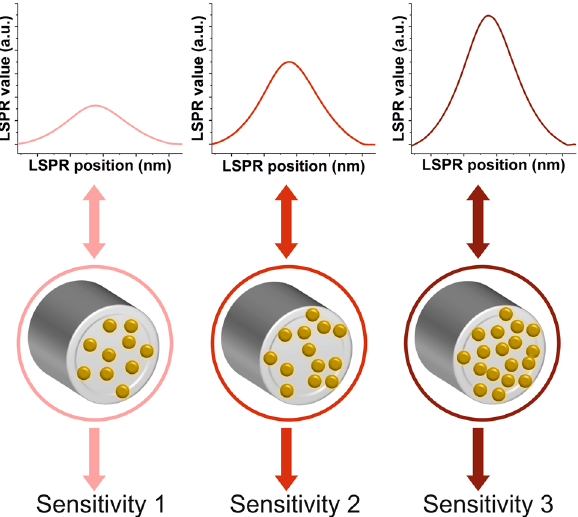
Figure 1. Scheme of the influence of the OF-LSPR sensor composition on its LSPR signal and performance. The density and degree of aggregation of the AuNPs immobilized on the facet of an optical fiber can be deduced from its LSPR signal. OF-LSPR sensors with different LSPR peak values render different sensitivities upon changes in their